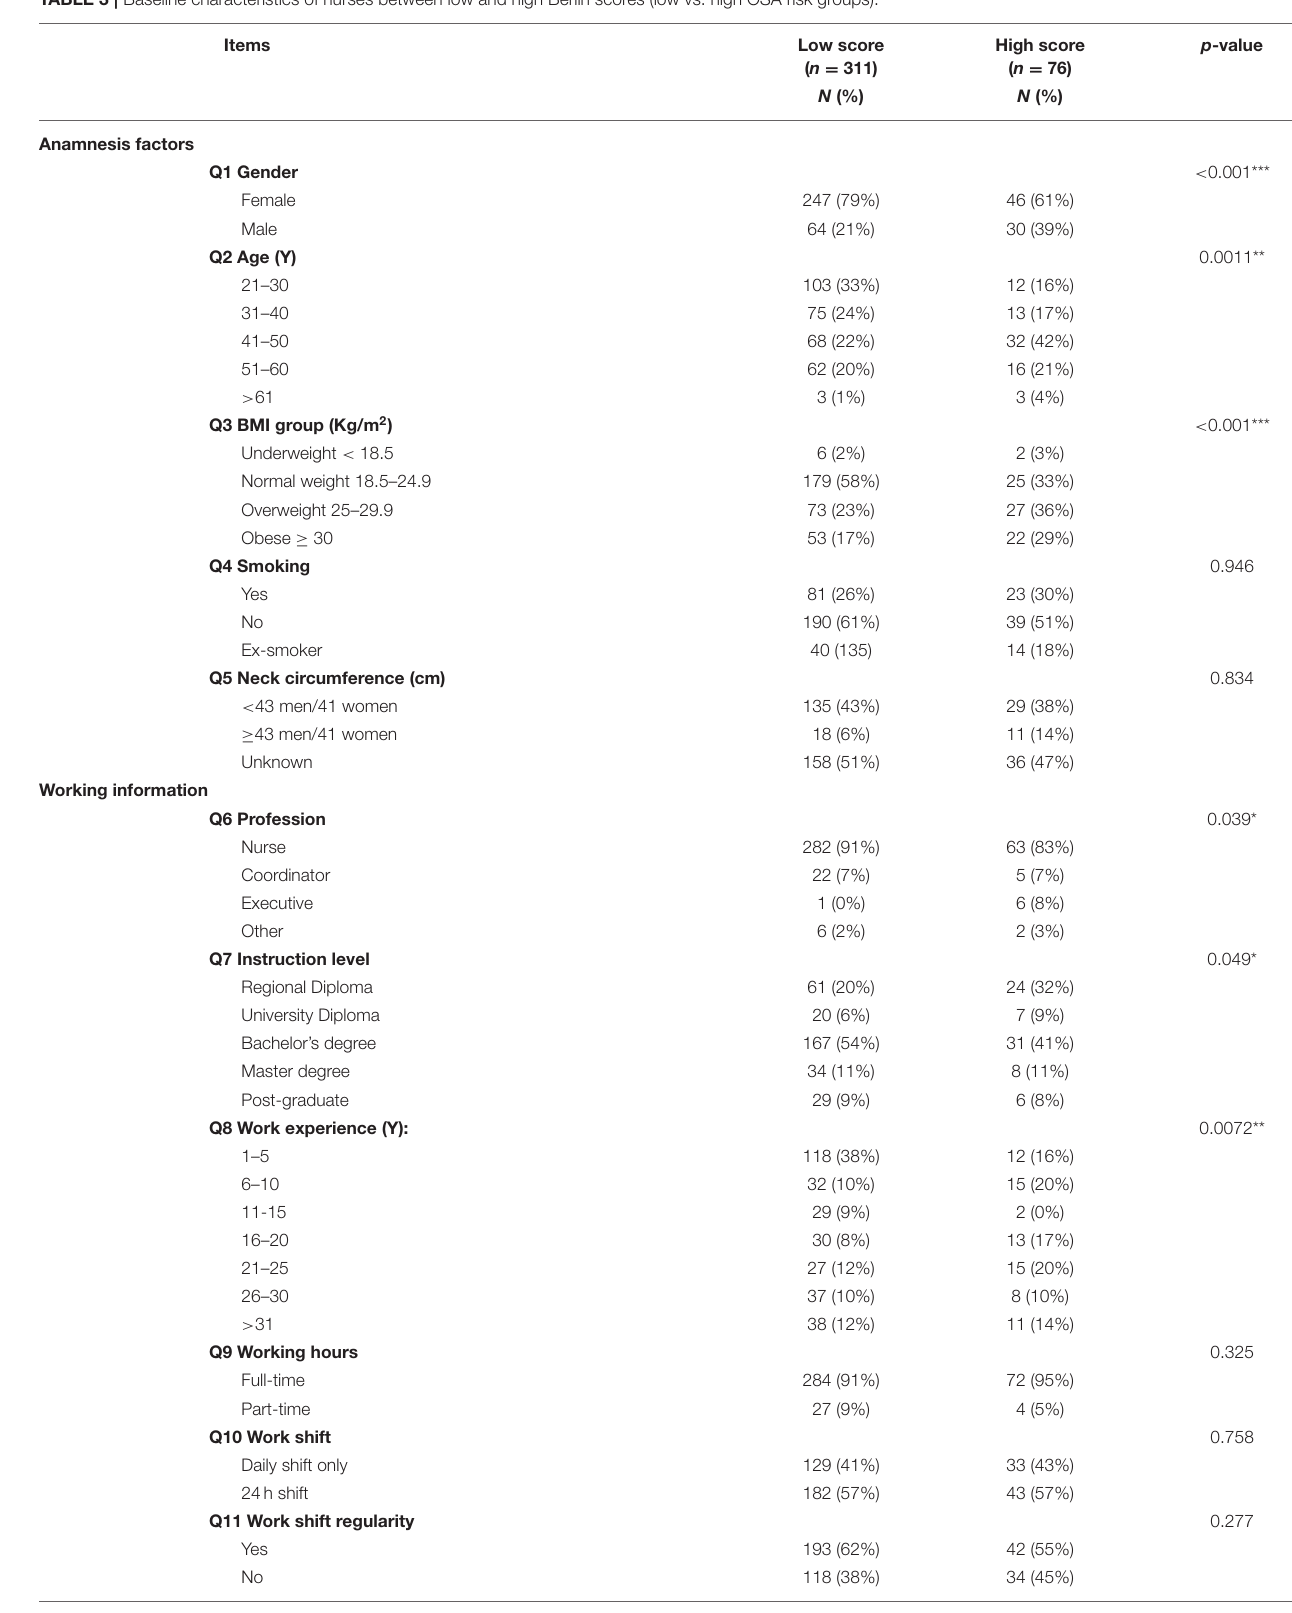
p -value High score ( n = 311) ( n = 76) N (%) N (%)